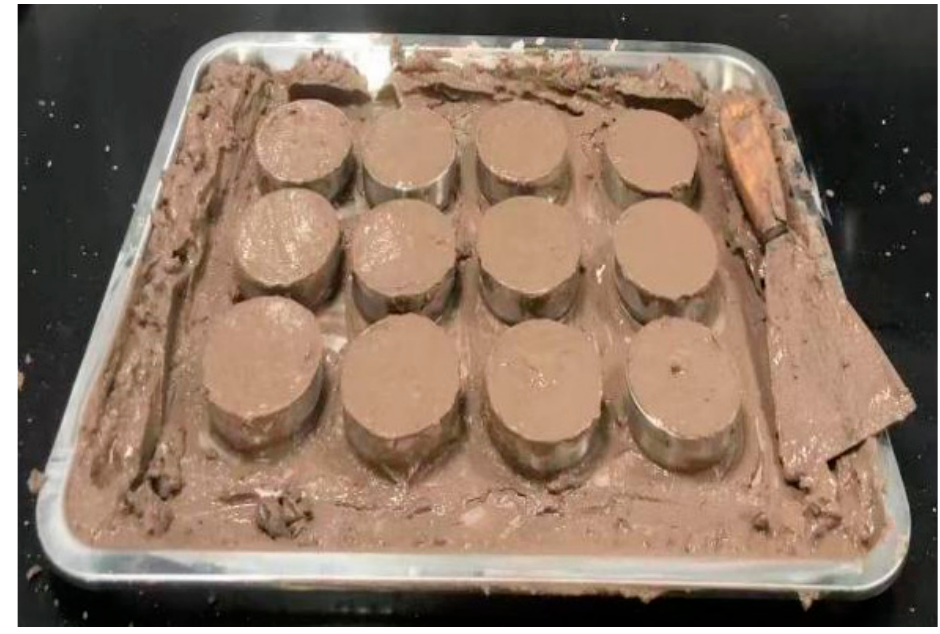
Figure 1. Shield residues.